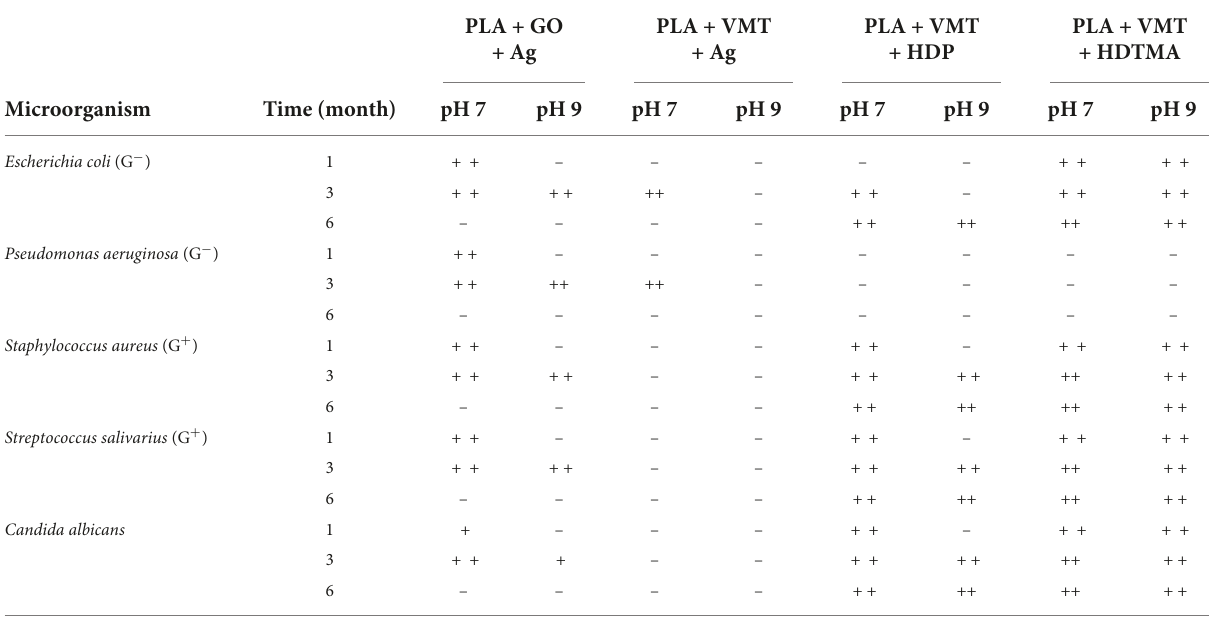
TABLE 1 Antimicrobial effect of leachates after degradation of the composites at 1, 3, and 6